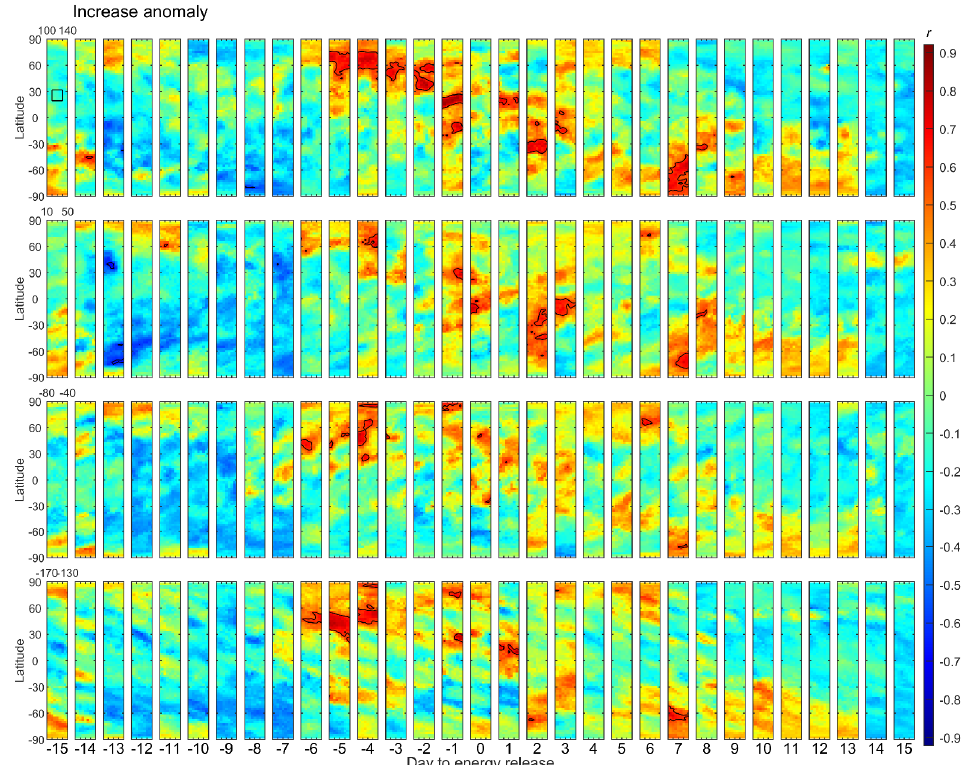
Figure 10. Same as Figure 9 for the results of occurrence times of the TEC increase anomalies.